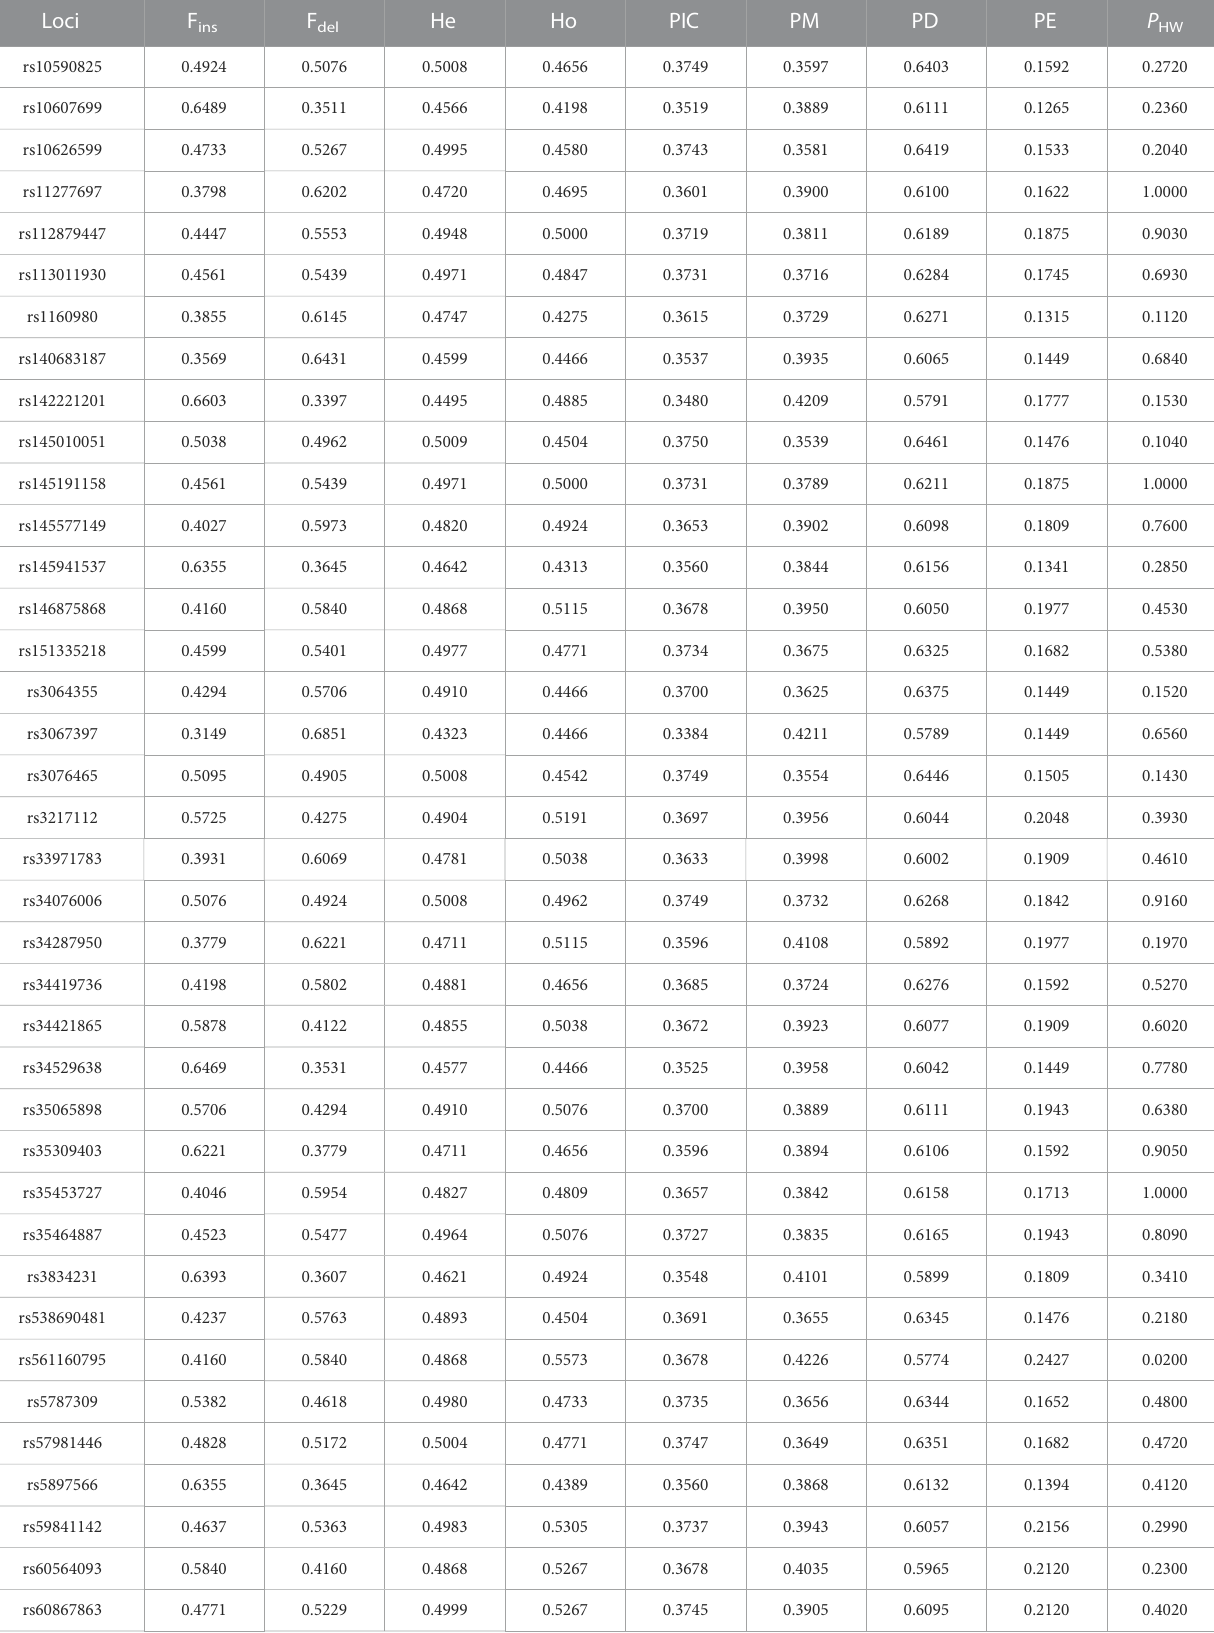
TABLE 1 Allelic frequencies and forensic parameters of 57 InDels in the studied Tujia group ( n = 262) (F ins , frequency of the insertion allele; F del , frequency of the deletion allele; P HW , p -values for the Hardy – Weinberg equilibrium tests).